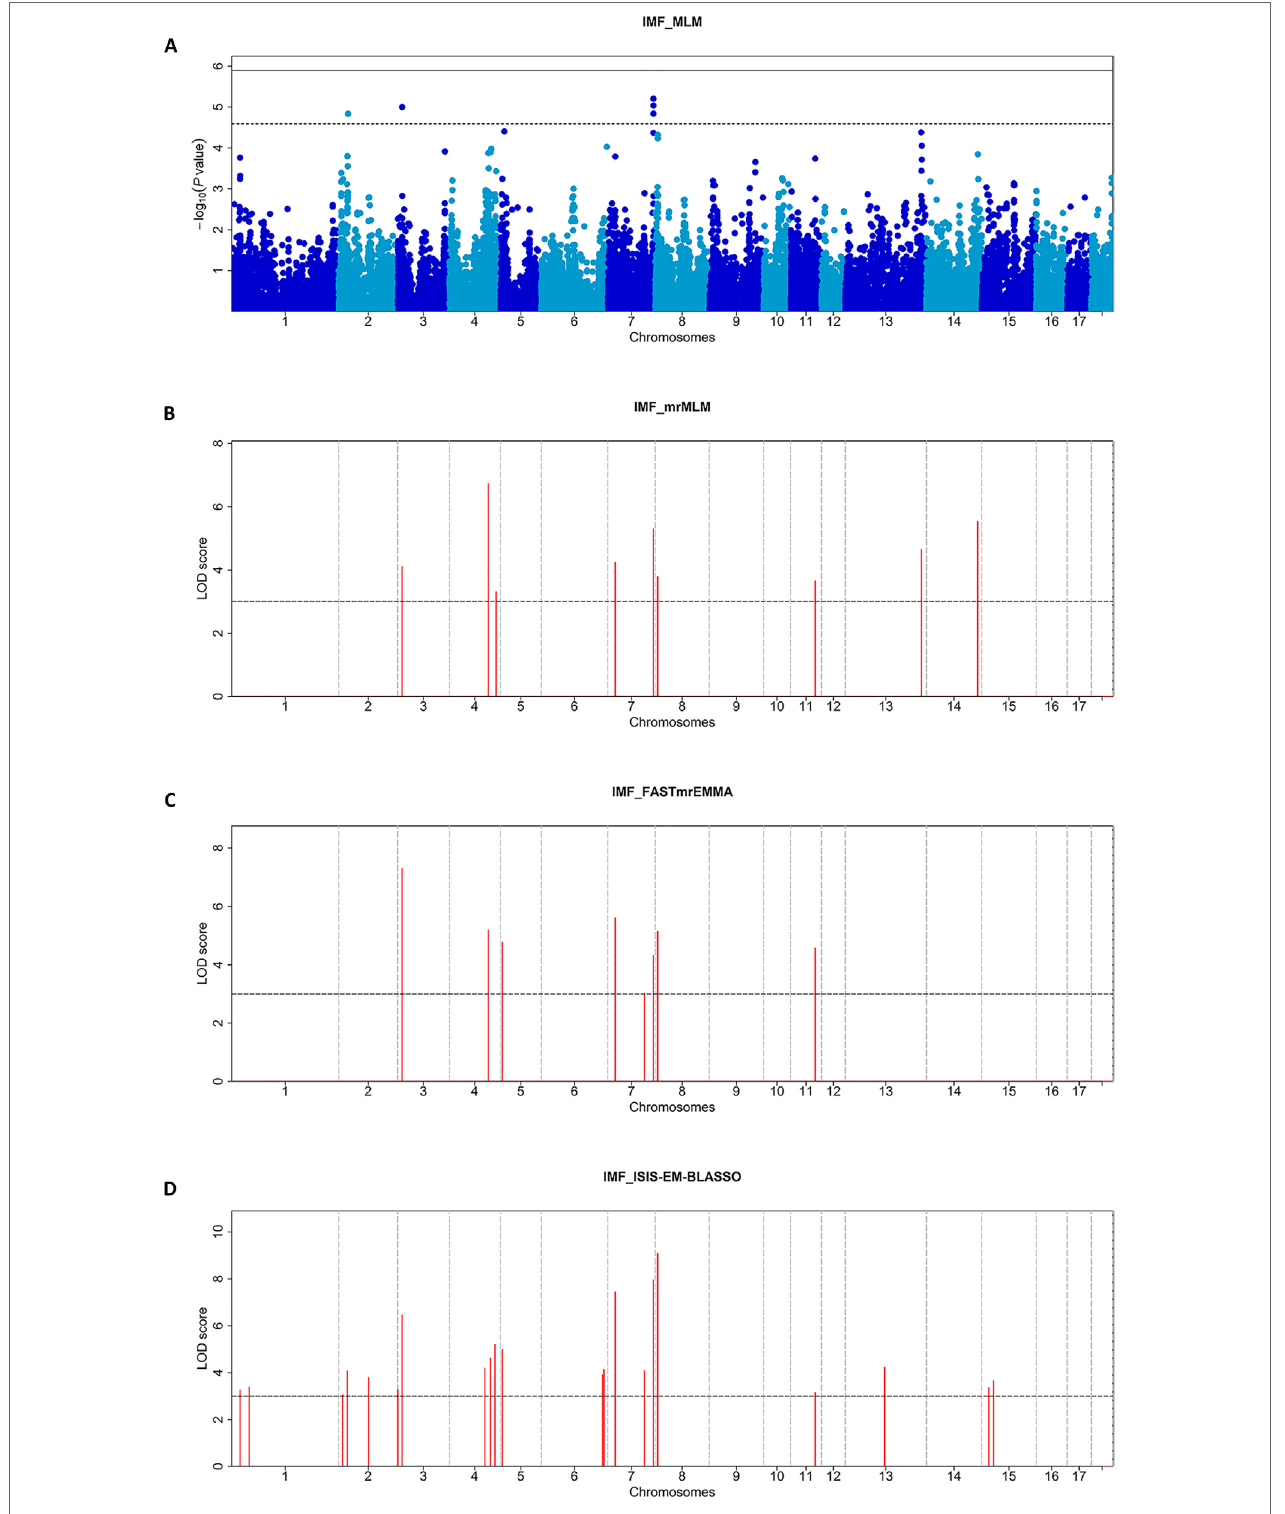
FIGURE 1 | Manhattan plots of the MLM (A) , mrMLM (B) , FASTmrEMMA (C) , and ISIS EM-BLASSO (D) analyses for the IMF Trait in Duroc pigs. (A) The Manhattan plots indicate -log10 ( P values) for genome-wide SNPs (y-axis) plotted against their respective positions on each chromosome (x-axis), and the horizontal line indicates the thresholds for significant (1.29E-06) and suggestive (2.58E-05) SNPs. (B–D) The Manhattan plots indicate LOD scores for genome-wide SNPs (y-axis) plotted against their respective positions on each chromosome (x-axis), and the horizontal lines indicate the thresholds for significance (LOD score =